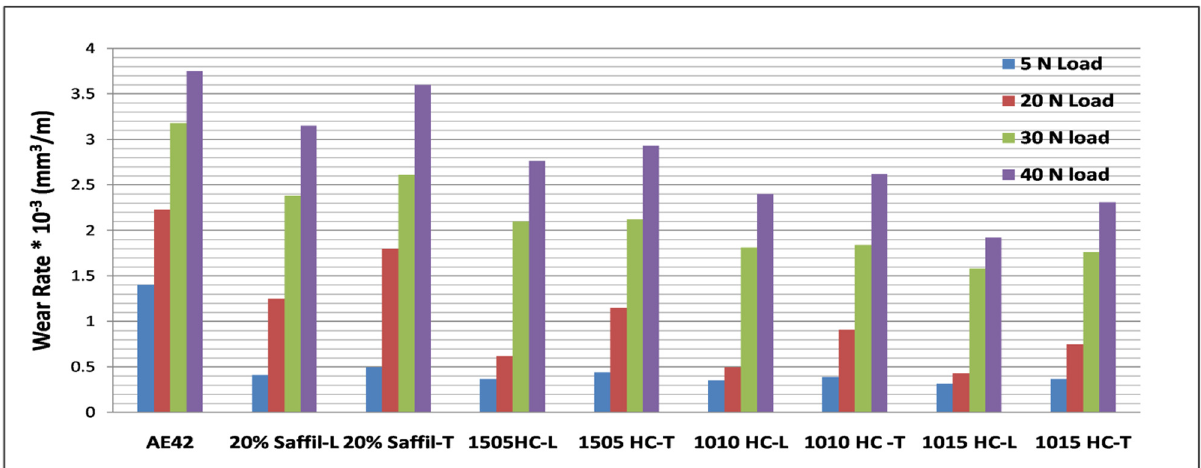
Figure 5: Comparison of wear rate for the AE42 alloy and its hybrid composites in Longitudinal direction ( L ) and Transverse direction ( T ) at di ff erent loading conditions ( 5, 20, 30, and 40 N ) , adapted from ref. [ 42 ]